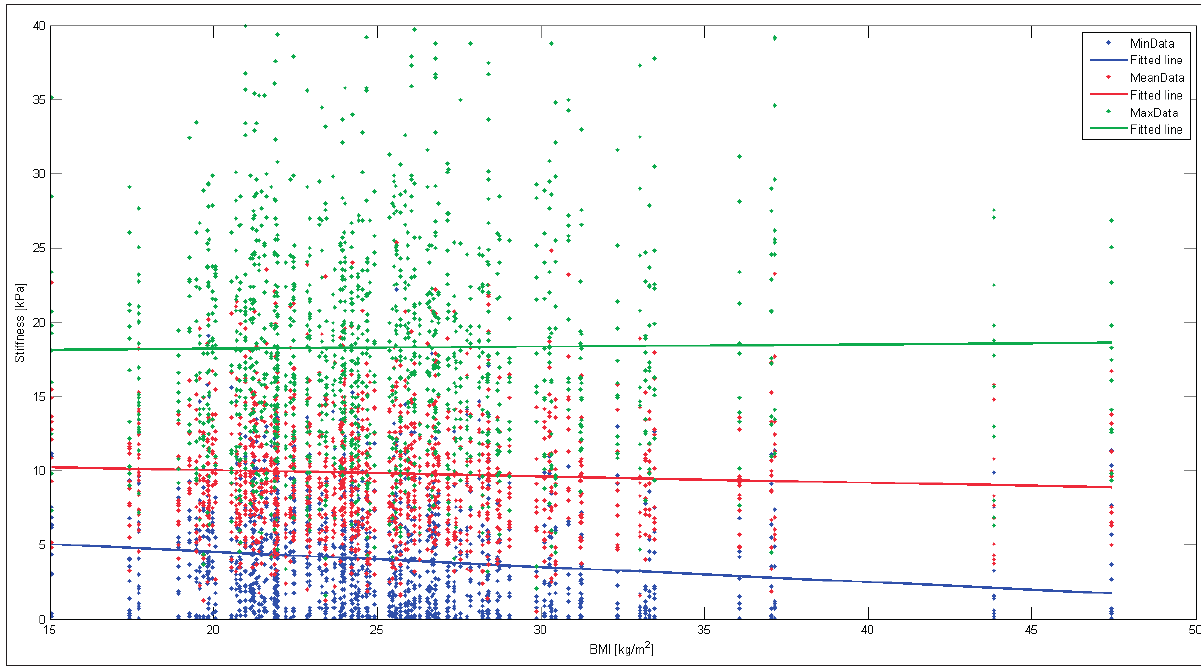
Fig. 4. Effect of BMI on maximum, mean, and minimum stiffness. The slope of the line for maxima (green): 0.016 [kPa m 2 /kg], 95% confidence interval: [−0.061, +0.093], slope of the line for mean (red): −0.043 016 [kPa m 2 /kg], 95% confidence interval: [−0.087, +0.002], slope of the line for minima (blue): −0.102 016 [kPa m 2 / kg], 95% confidence interval: [−0.139,